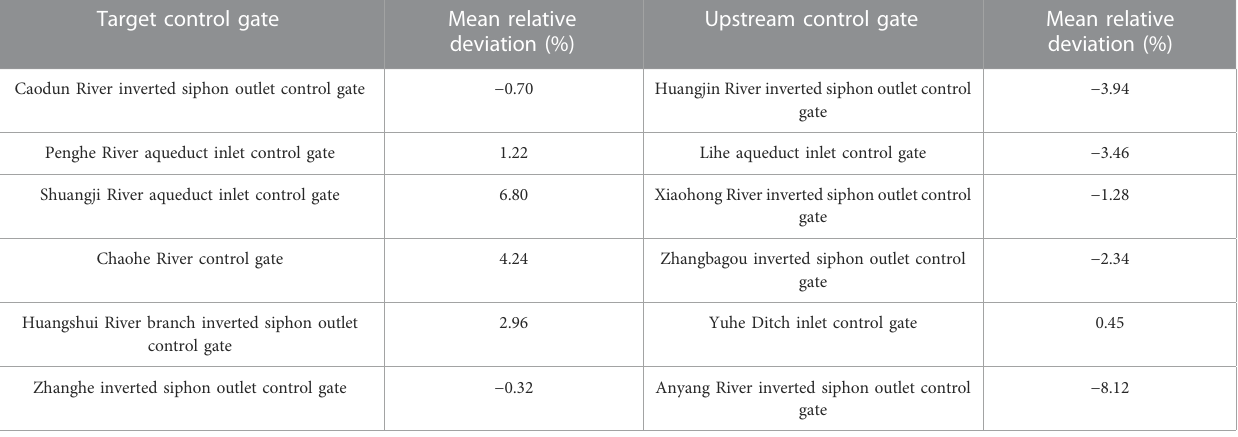
TABLE 2 Statistics of the average relative deviation of the selected control gate and the upstream control